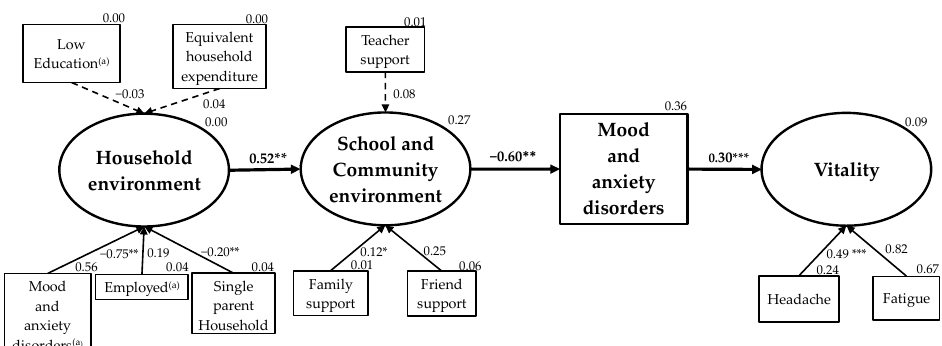
Figure 4. Covariance structure modeling of environments and adolescent mental health (ECO-AM model). Model fit statistics: goodness-of-fit index = 0.984, adjusted goodness-of-fit index = 0.971, comparative fit index = 0.898, root mean square error of approximation = 0.040, the degrees of freedom = 25. Solid lines represent significant standardized path coefficients (* p < 0.1, ** p < 0.05, *** p < 0.001), dotted lines show non-significant standardized path coefficients. Measurement items for mood and anxiety disorders and error variance are not shown. (a) The household head.